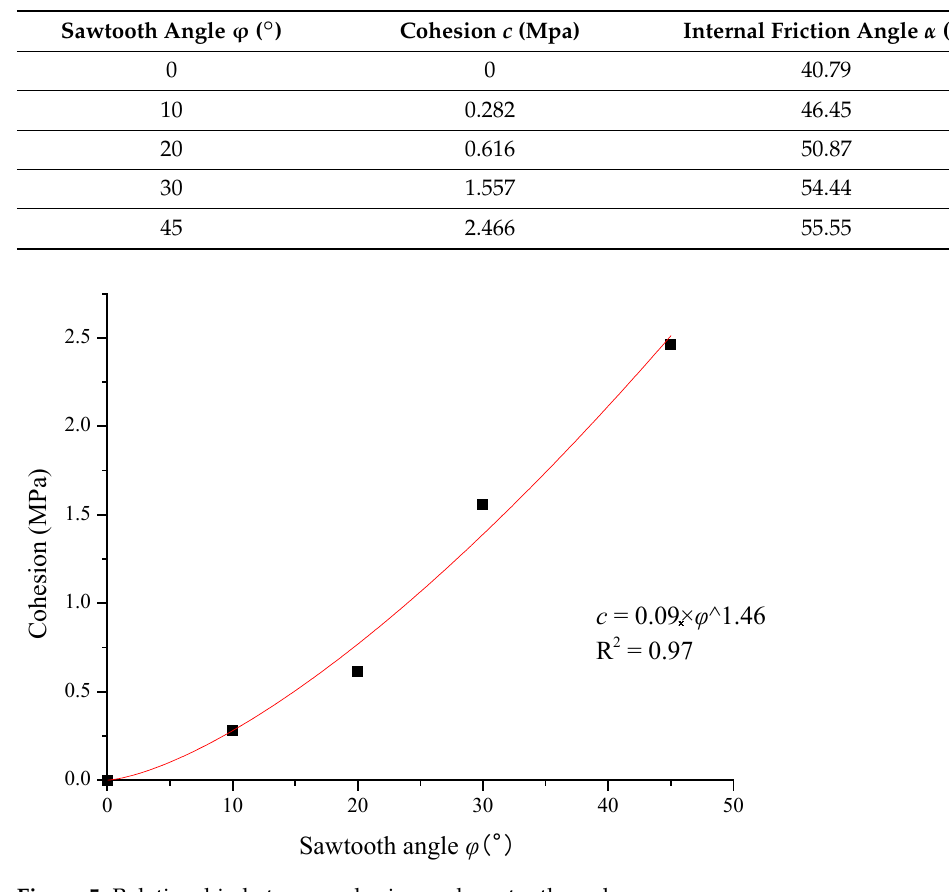
Table 2. Shear strength parameters of joints.